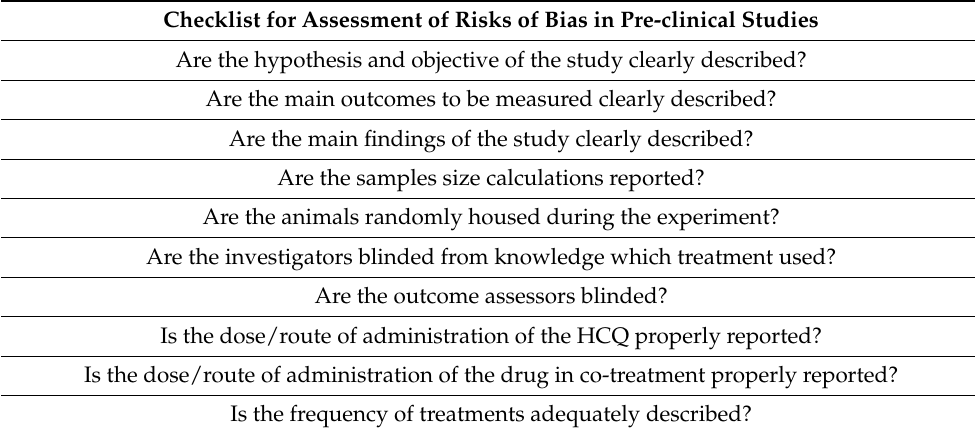
Table 4. Checklist for assessment of risks of bias in pre-clinical studies [75].